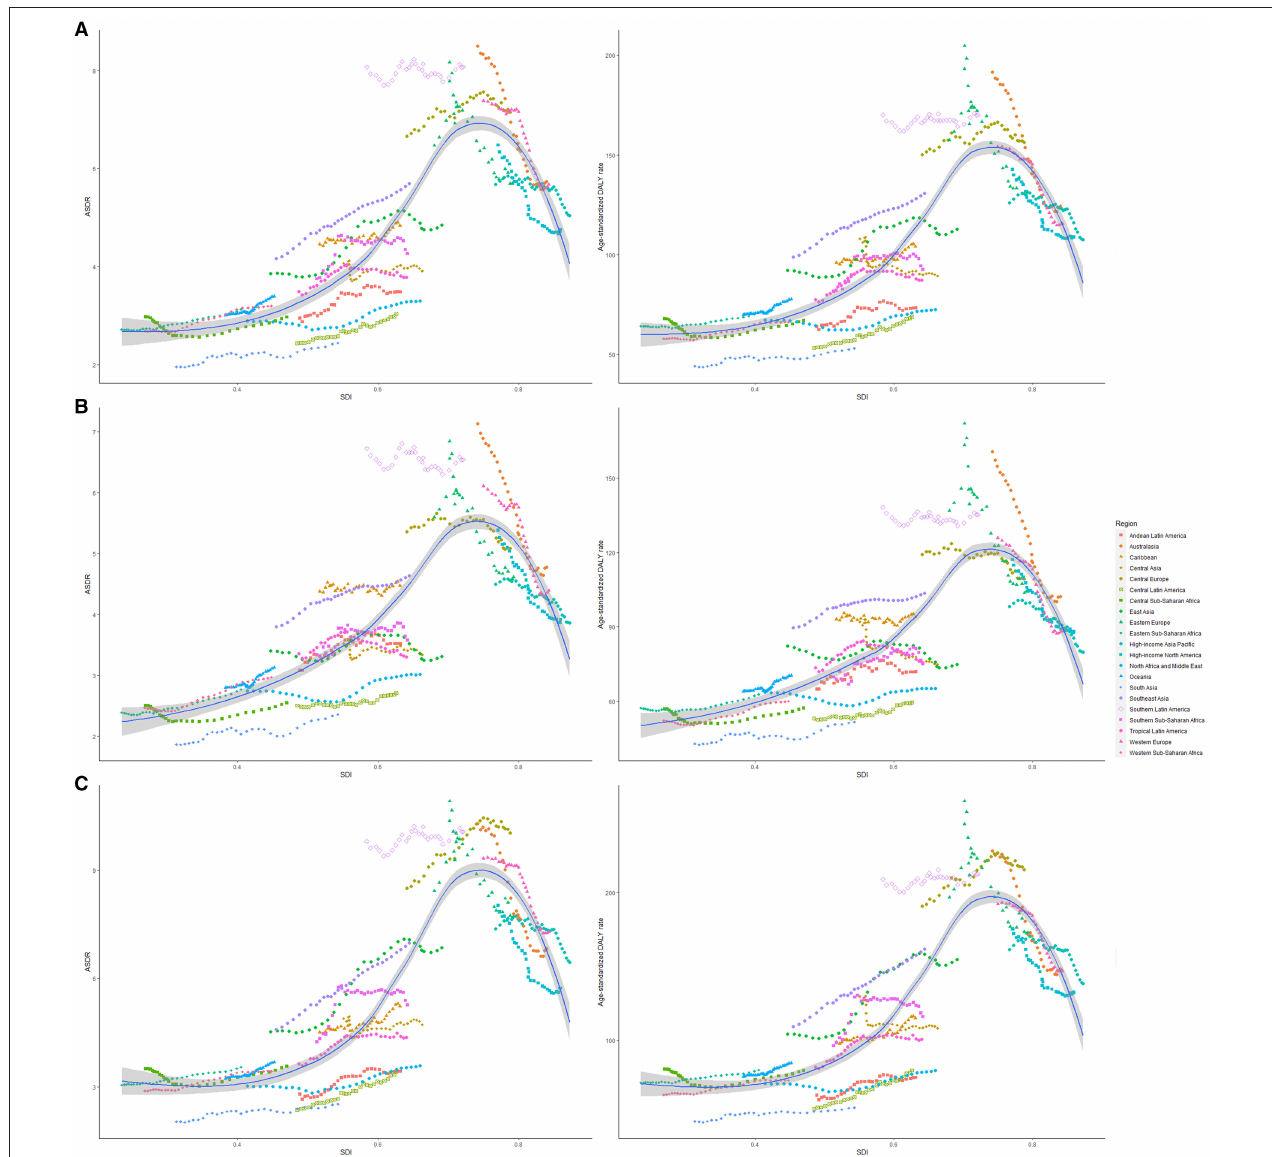
FIGURE 4 | The ASRs of dietary risk related colorectal cancer among 21 regions based on SDI in 2019. The vertical axis is the age-standardized death and DALY rate (per 100,000 person-years), and the horizontal axis is the SDI value in 2019. Each combination of colors and shapes represents a region. Each point represents the age-standardized death and DALY rate (per 100,000 person-years) that year in each region. Each combination of the same color and shape, from front to back, represents the data for each year from 1990 to 2019. (A) ASDR or age-standardized DALY rate for both genders; (B) ASDR or age-standardized DALY rate for women; and (C) ASDR or age-standardized DALY rate for men. ASDR, age-standardized death rate; DALY, disability-adjusted life-year; SDI, socio-demographic